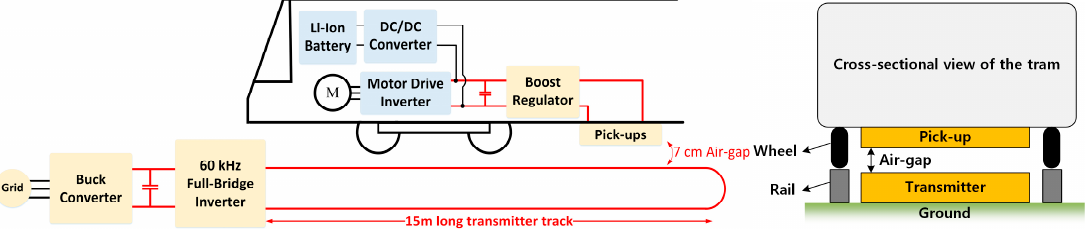
Figure 1. Overall configuration of the target tram system.